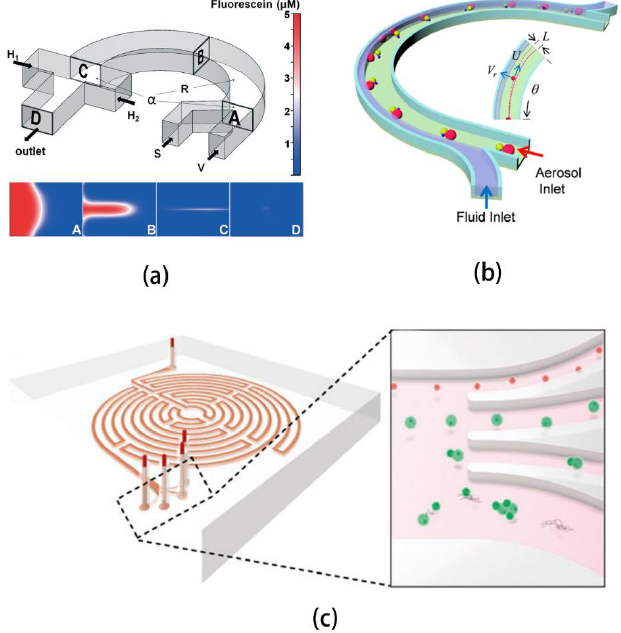
Figure 8. Applications of arcuate channel inertial microfluidics. ( a ) Three-dimensional hydrodynamic focusing device which can serve as a basis for microfluidic flow cytometry. Ref. [73]. Copyright (2013), with permission from Royal Society of Chemistry; ( b ) Continuous airborne microorganism collector for applications in real-time bioaerosol detection. Ref. [74]. Copyright (2017), with permission from American Chemical Society; ( c ) Labyrinth formed by high number of arcuate channels to separate satellite cells and fibroblasts. Ref. [75].